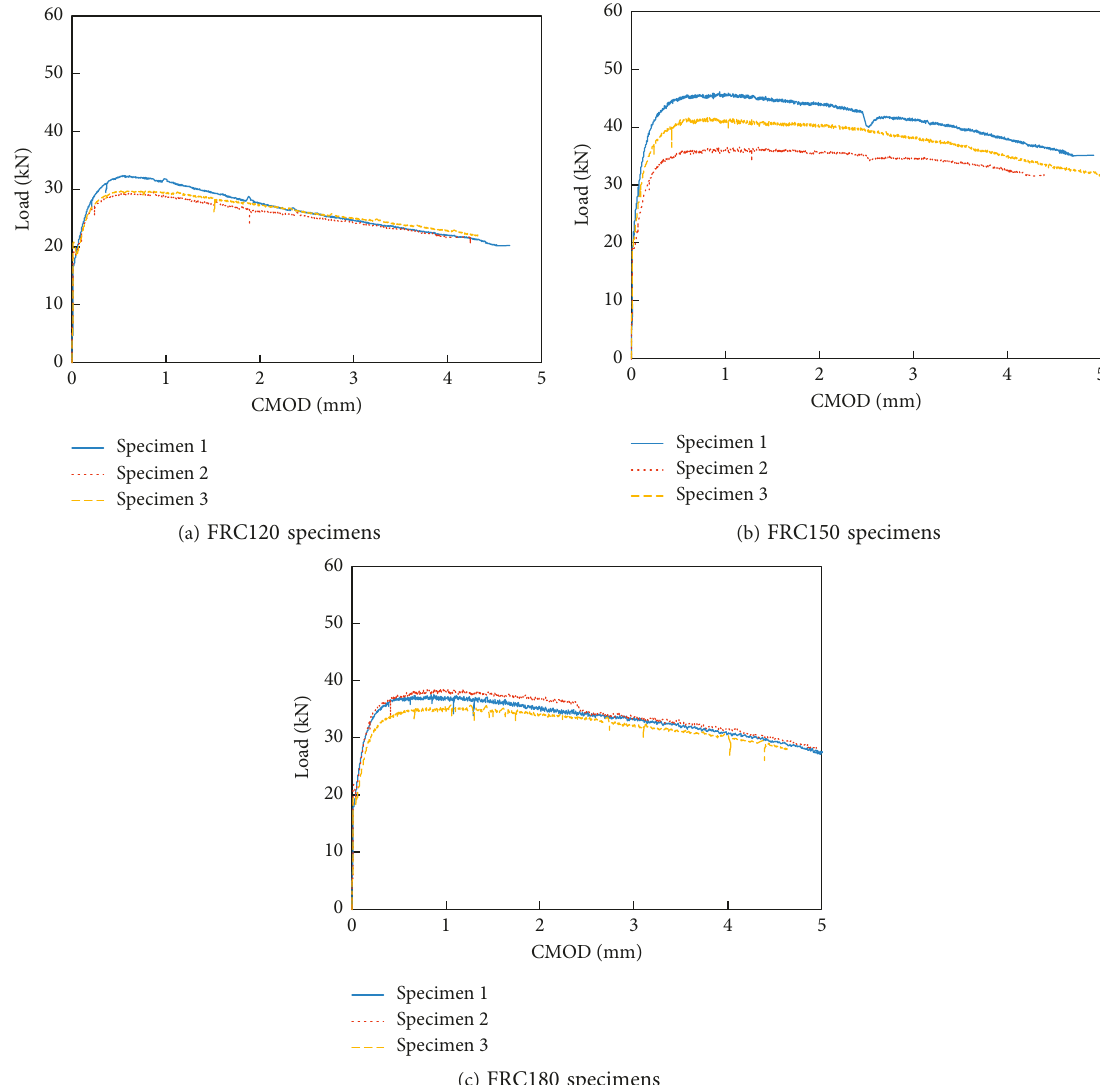
Figure 2: Load-CMOD relationship